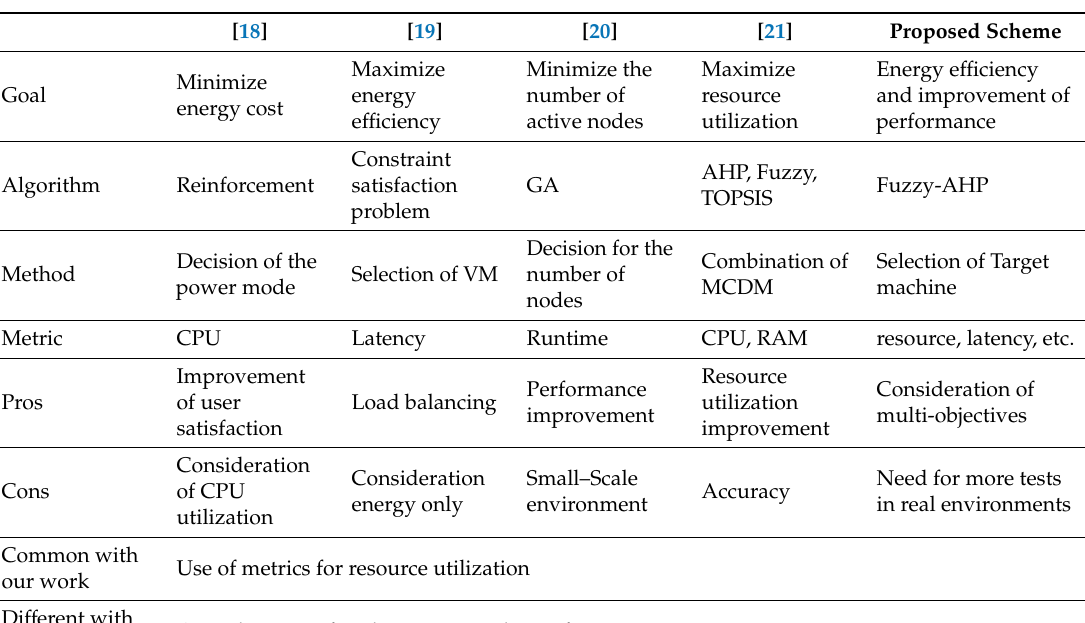
Figure 2. Approaches for decision-making. Table 1. Related work on